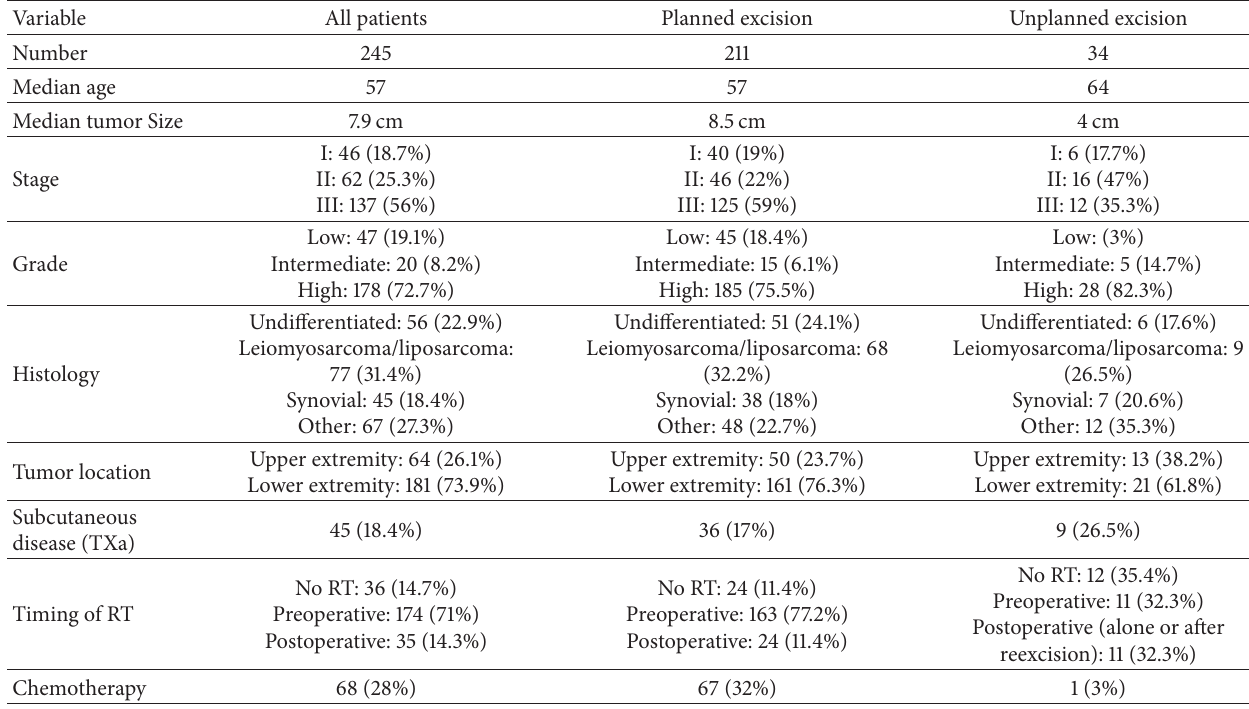
Table 1: Patient, disease, and treatment characteristics between patients who underwent UE and